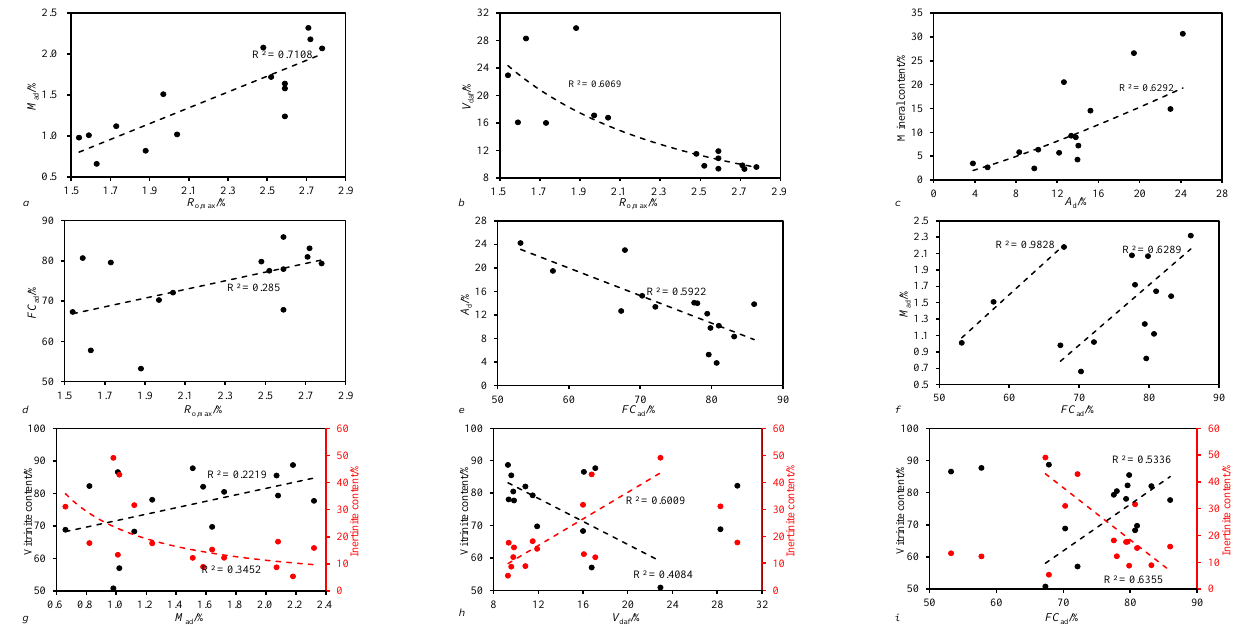
Figure 2. The relationships between proximate analysis parameters.